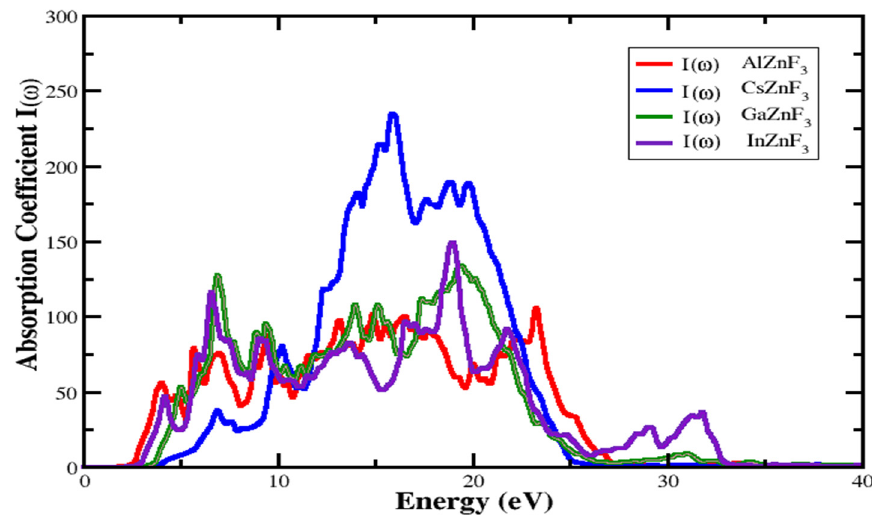
Figure 8. Absorption coefficient of XZnF 3 (X = Al, Cs, Ga, In).